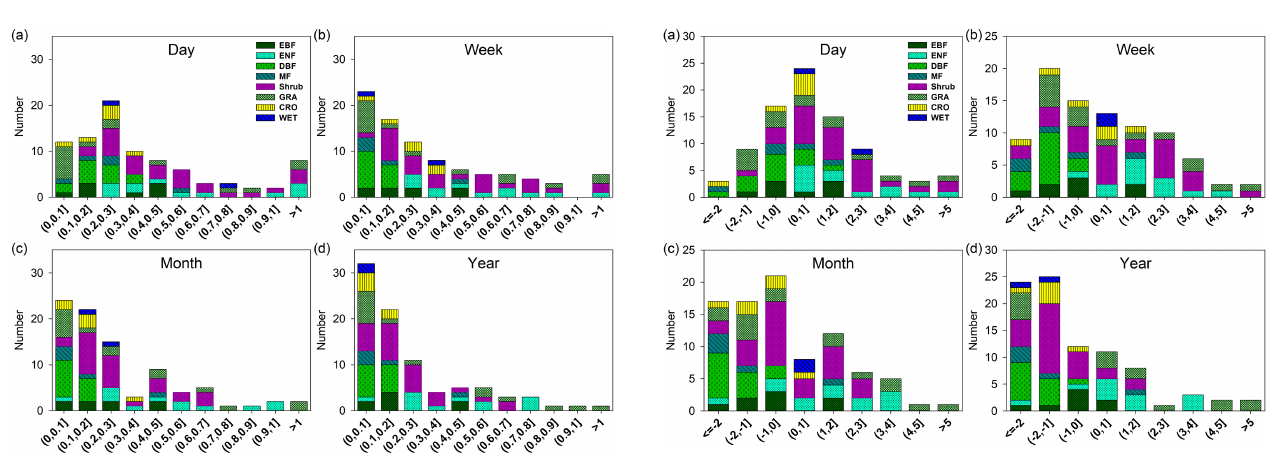
Figure 5. Distribution of the key parameter 1 /b at the daily scale (a) , weekly scale (b) , monthly scale (c) , and yearly scale (d) . EBF, evergreen broadleaf forests (8); ENF, evergreen needleleaf forests (27); DBF, deciduous broadleaf forests (13); MF, mixed forests (5); shrub (12), closed shrubland, open shrublands, woody savannas, and savannas; GRA, grassland (15); CRO, croplands (6); WET, permanent wetlands (2).